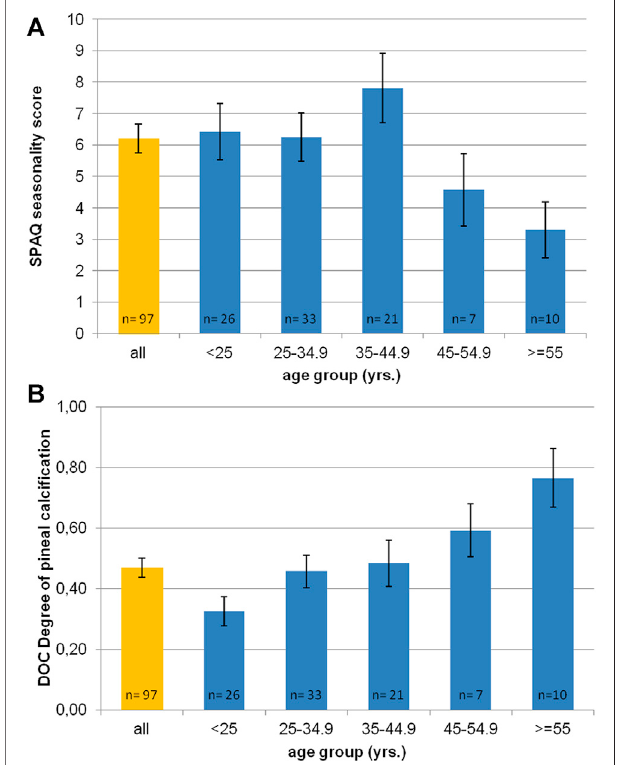
FIGURE2| Agedistributionof (A) SPAQseasonalityscoreand (B) DOC scores (degree of pineal calci fi cation). Orange bar represents mean value of whole sample. Blue bars represent mean values per age-group (in 10 yrs spans). Error bars indicate standard error of mean.